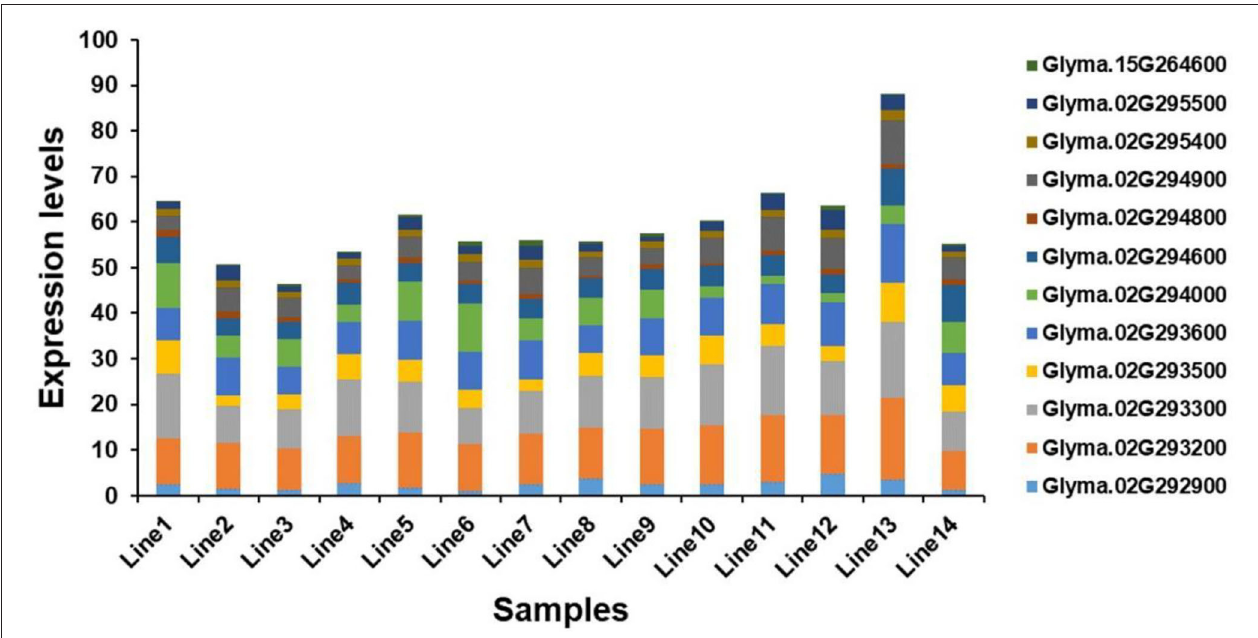
FIGURE 6 | Expression level analysis of candidate genes. Line 1 to Line 7 are germplasms with low-soluble sugar content, and Line 8 to Line 14 are germplasms with high-soluble sugar